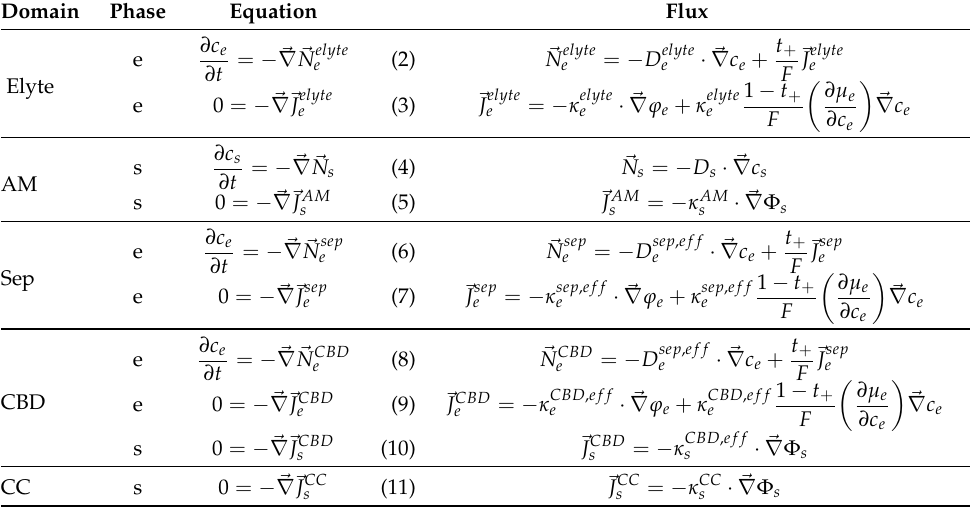
Table 1. List of governing equations used for the spatially resolved electrochemical simulations. The effective transport parameters in the CBD and separator are calculated according to Equation